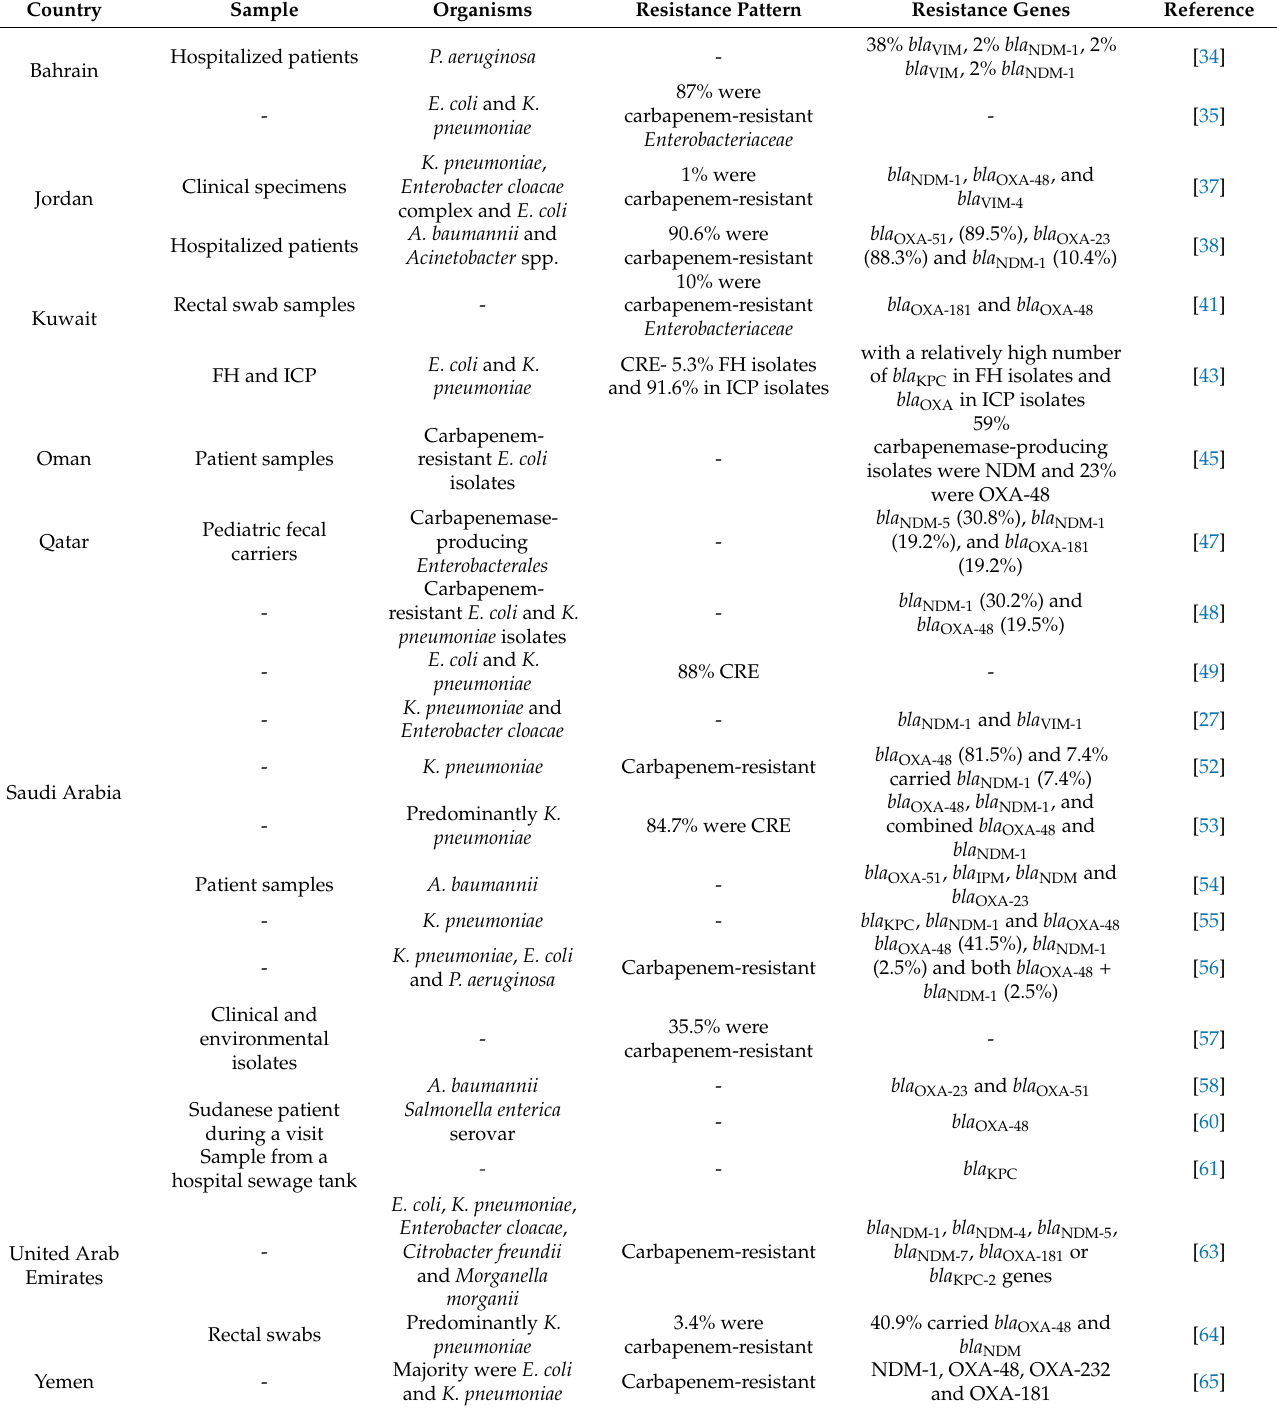
Table 2. Investigations of Carbapenemase-based infections in the Arabian